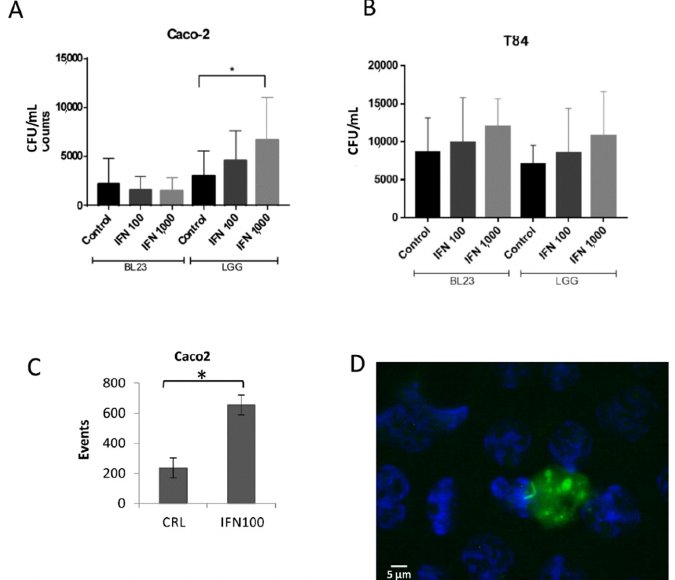
Figure 2. Gentamicin assays used to determine internalization of BL23 and LGG after the treatment of epithelial cells with 100 and 1000 UI/mL IFN- γ . ( A ) Internalization using Caco-2 and ( B ) T84 cells. Data shown are means of internalized bacteria per mL with standard deviation in all experiments (results from four separate assays, with three internal replicates per condition). ( C ) Effect of 100 UI/mL IFN- γ on the internalization of BL23 [pT1-GR-p127] determined by flow cytometry; graph represents the means and standard deviation of red fluorescent events in two different assays with at least three determinations. ( D ) Selected epifluorescence microscope image of Caco-2 cells incubated with GFP-expressing L. paracasei BL23 [pT1-GR::p127] after the treatment with 1000 U/mL IFN- γ . The white scale bar represents 5 µm. Differences between groups compared with Tamhane’s test. * p < 0.001.